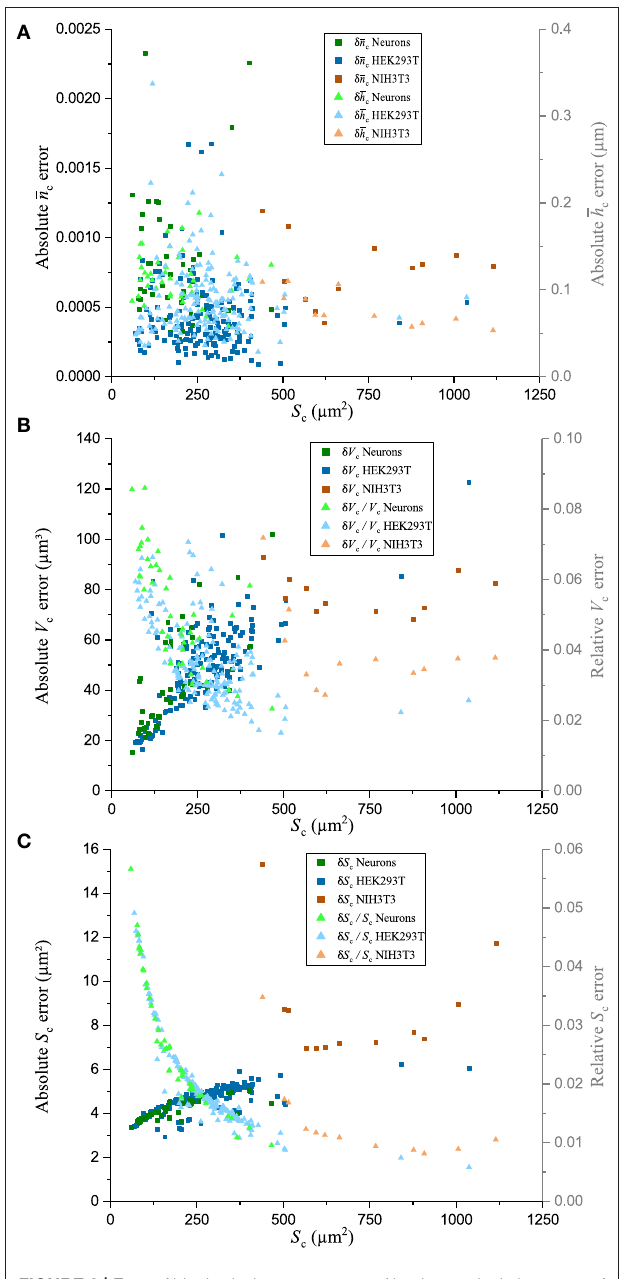
FIGURE 6 | Error of biophysical measurements. Absolute and relative errors of numerous biophysical measurements as a function of S c for three cell types in culture, including primary neurons, and HEK293T and NIH3T3 cells. Data points plotted with darker squares are in relation to the left axis and data points plotted with lighter shade triangles are in relation to the right axis. (A) Plots of the absolute n c error (left) and absolute h c error (right), (B) absolute (left) and relative (right) V c error, and (C) absolute (left) and relative (right) S c error.